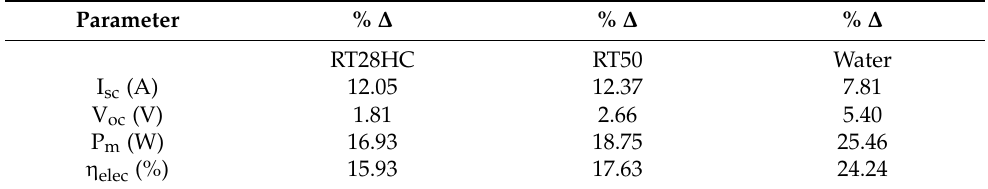
Table 2. Comparison of the relative percentage increase (% ∆ ) in the output electrical parameters of the WICPV system with PCM and water cooling compared with a naturally ventilated system.